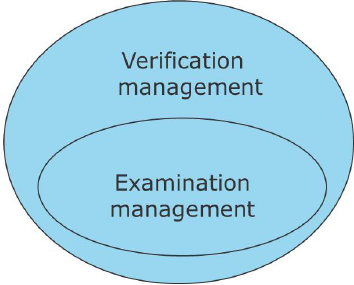
Figure 2: Verification and examination management.